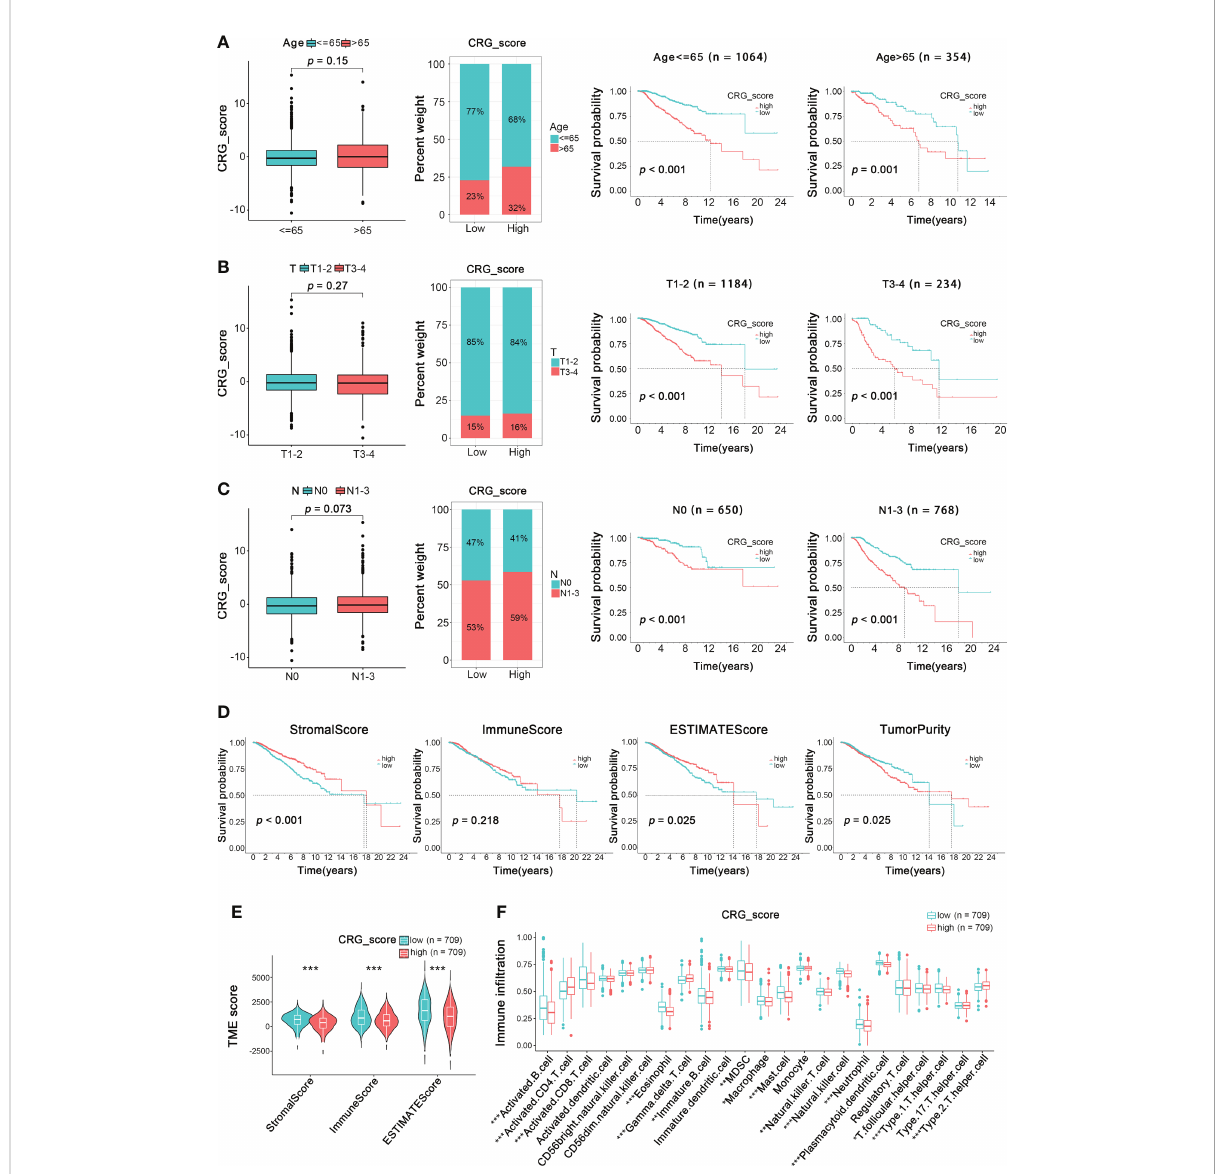
FIGURE 8 Relationship of Clinical Characteristics and TME Characteristics with CRG_score in the BRCA Training Cohort. The relationship between age (A) , T (B) , N (C) and CRG_score. The TNM system of cancer staging re fl ects the extent of tumor growth, where primary tumor (T), and nodal status for metastasis (N) (Wilcoxon test for boxplot; Log-rank test for survival analysis). (D) Survival analysis of ImmuneScore, StromalScore, ESTIMATEScore, and TumorPurity in BRCA patients (Log-rank test). (E) The TME score of the two CuproptosisClusters in the high and low CRG_score groups (Spearman test). (F) The abundance of 23 in fi ltrating immune cell types in the high and low CRG_score groups (Spearman test). * p < 0.05, ** p < 0.01, *** p <